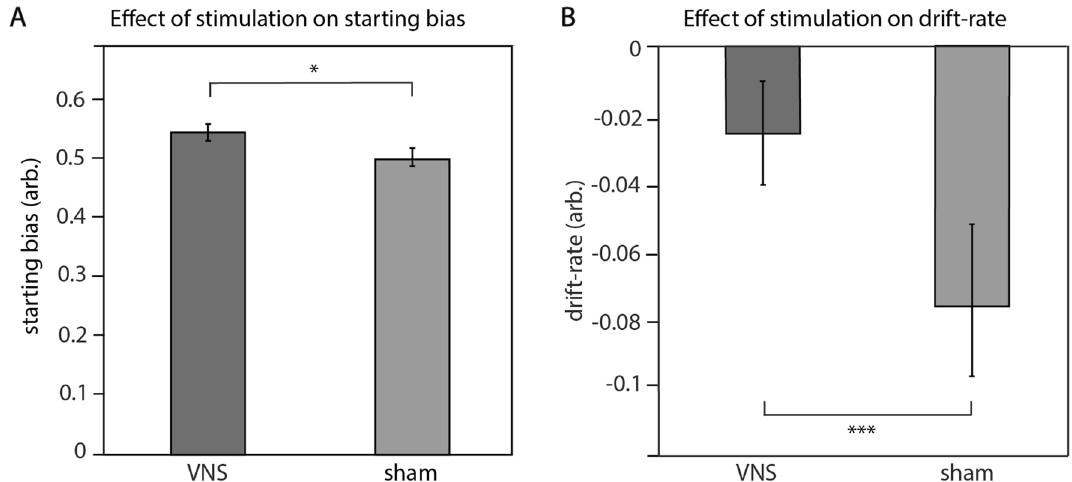
Figure 3. Effect of stimulation on DDM parameters. A chi-square difference test comparing the goodness of fit of the two competing models used in DDM analysis demonstrated stimulation effects on ( A ) starting bias (p = 0.01) and ( B ) drift-rate (p < 0.001). Stimulation increased the starting bias towards cooperation and shifted drift-rate towards zero. Bar graphs illustrate mean ± SEM parameters across